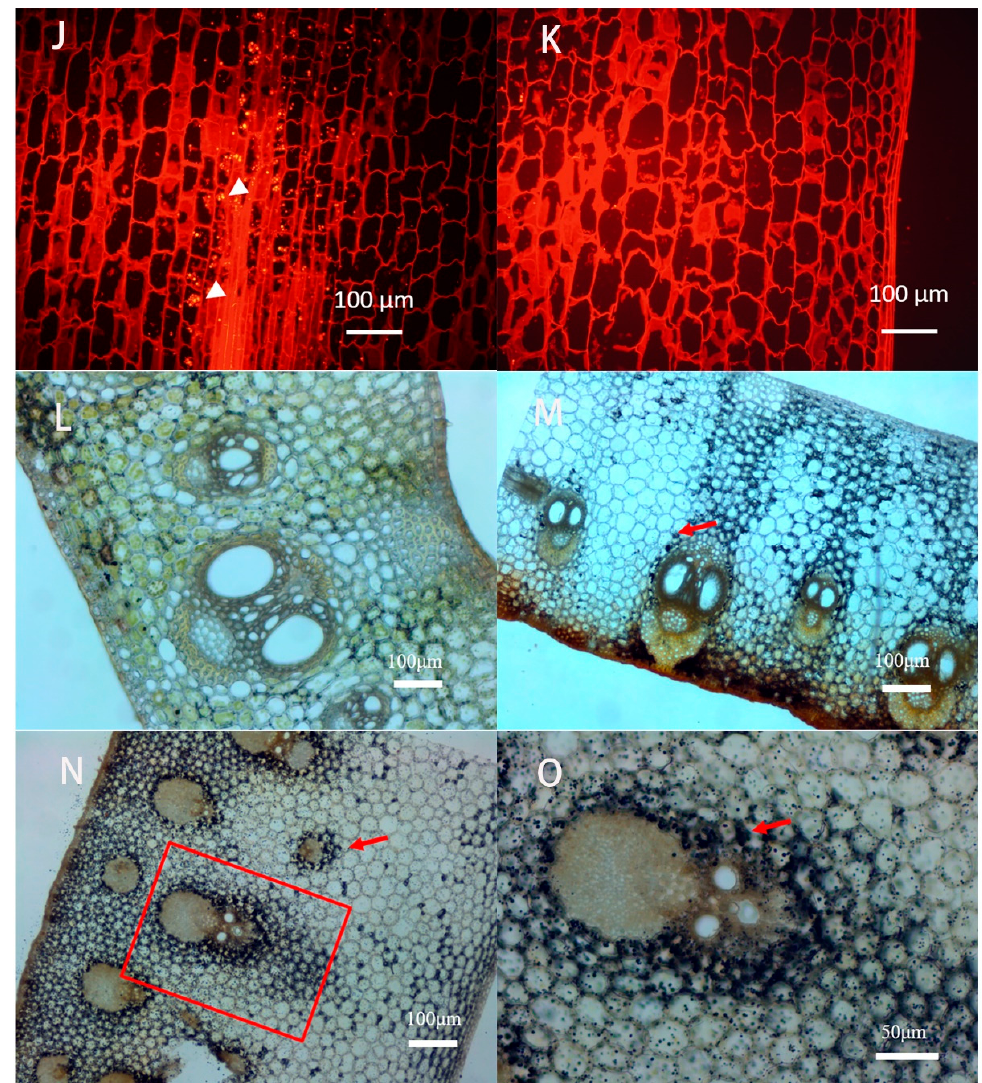
Figure 5. Distribution of starch grains in the culm sheath under a fluorescence microscope; potassium iodide stain was used to indicate starch. ( A – C ) Sheath blades, sheath upper, and sheath base of culm sheath at the base of bamboo shoot. ( D – F ) Sheath blades, sheath upper, and sheath base of culm sheath at the middle of bamboo shoot. ( G – I ) Sheath blades, sheath upper, and sheath base of culm sheath at the upper of bamboo shoot. ( J , K ) Longitudinal section of a culm sheath of parenchymal cells surrounding the vascular bundles. ( K ) Parenchymal cells located away from vascular bundles. ( L ) Sheath blades. ( M ) Sheath upper. ( N ) Sheath base. ( O ) Local amplification of N. xy, xylem; ph, phloem; sc, sclerenchyma. The white triangles indicate starch grains. The red rectangle indicates vascular bundle. The red arrows indicate starch grains.